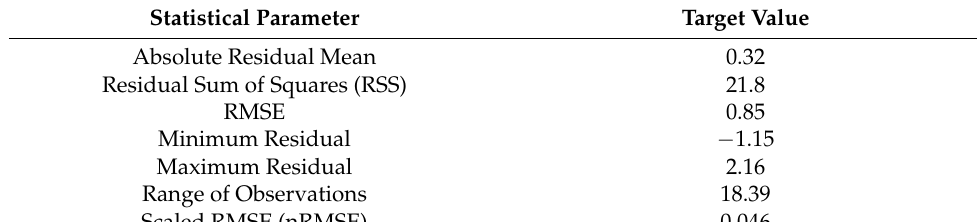
Table 2. Model statistics for the considered head targets. Statistics refer to S1.